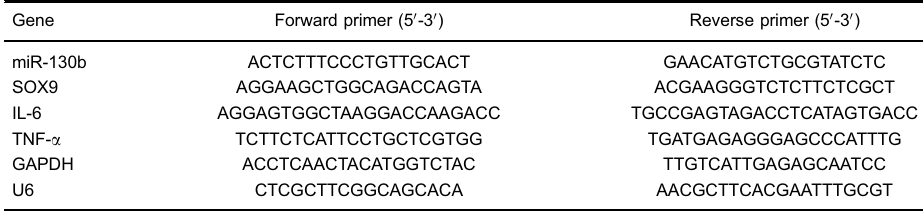
Table 1. Primer sequences for